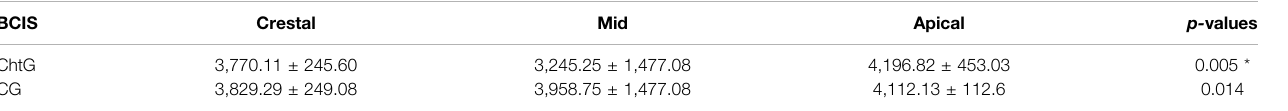
BCIS, bone in contact to the implant surface; ChtG, chitosan group; CG, Control Group. General linear model ( p ≤ 0.05). * Statistical signi fi cance.